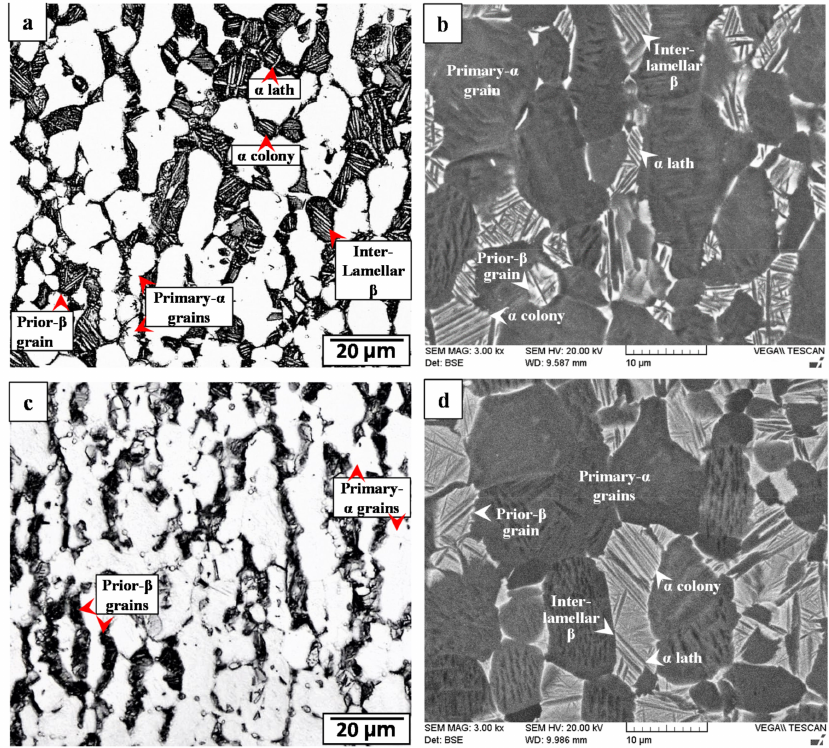
Figure 5. Ti-6242 PM microstructure: ( a , b ) as-received (OM and SEM) and ( c , d ) SRAed (OM and